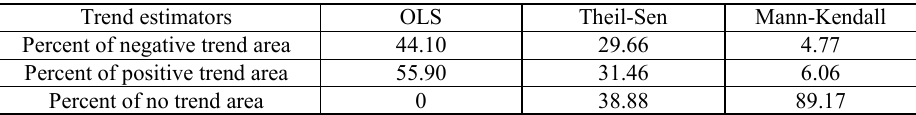
Figure 4. Spatial patterns of vegetation dynamic trends using OLS (a), Theil-Sen (b) and Mann-Kendall trend test (c) Table 1. Quantitative results of applied vegetation dynamic trends